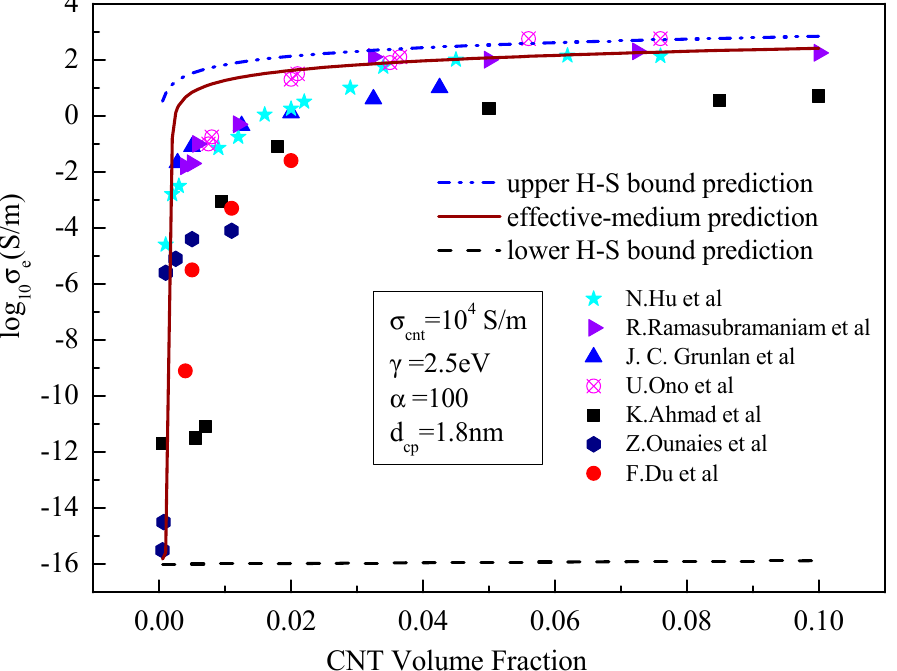
Figure 2. Comparison between the prediction results and existing experimental data [21,23–28] without considering the tunnelling effect.